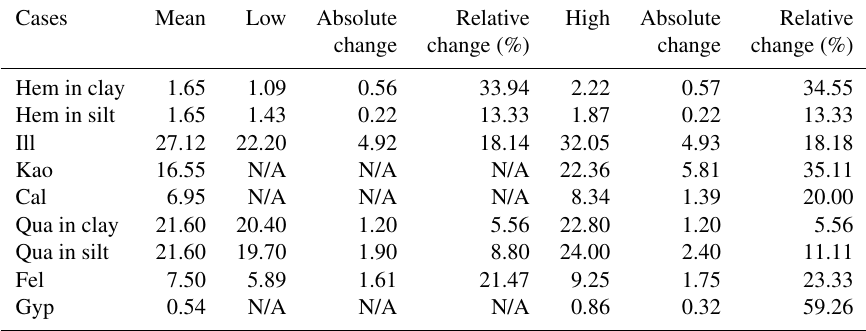
Table 4. Simulated mineral mass fraction and fractional absolute and relative changes (in percentage, %) in mineral mass fraction from the mean to the high bound in the global average.